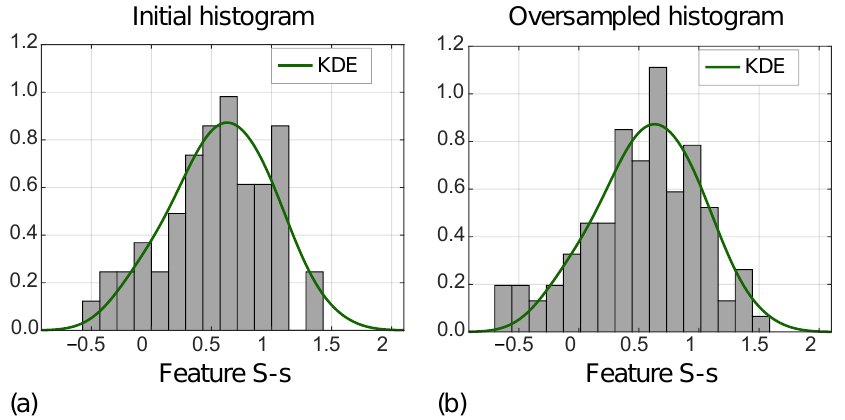
Figure 7. Normalized histograms of feature S-s [ZOT,A] (i.e., F63) referred to ID ( a ) and OD ( b ) for MVI −